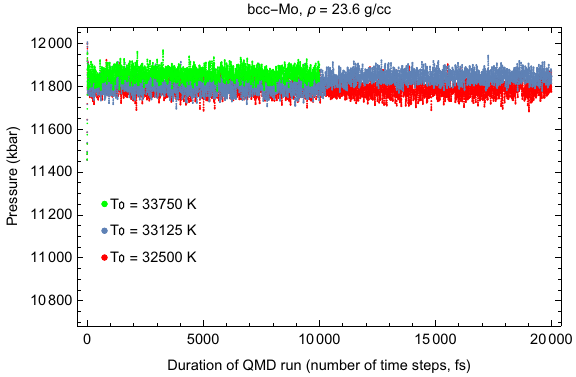
Figure 2. The same as in Figure 1 for the time evolution of pressure (in kbar; 10 kbar = 1 GPa): During melting, P increases from ∼ 1180 GPa for the superheated state to ∼ 1185 GPa for the liquid state at the corresponding melting point.